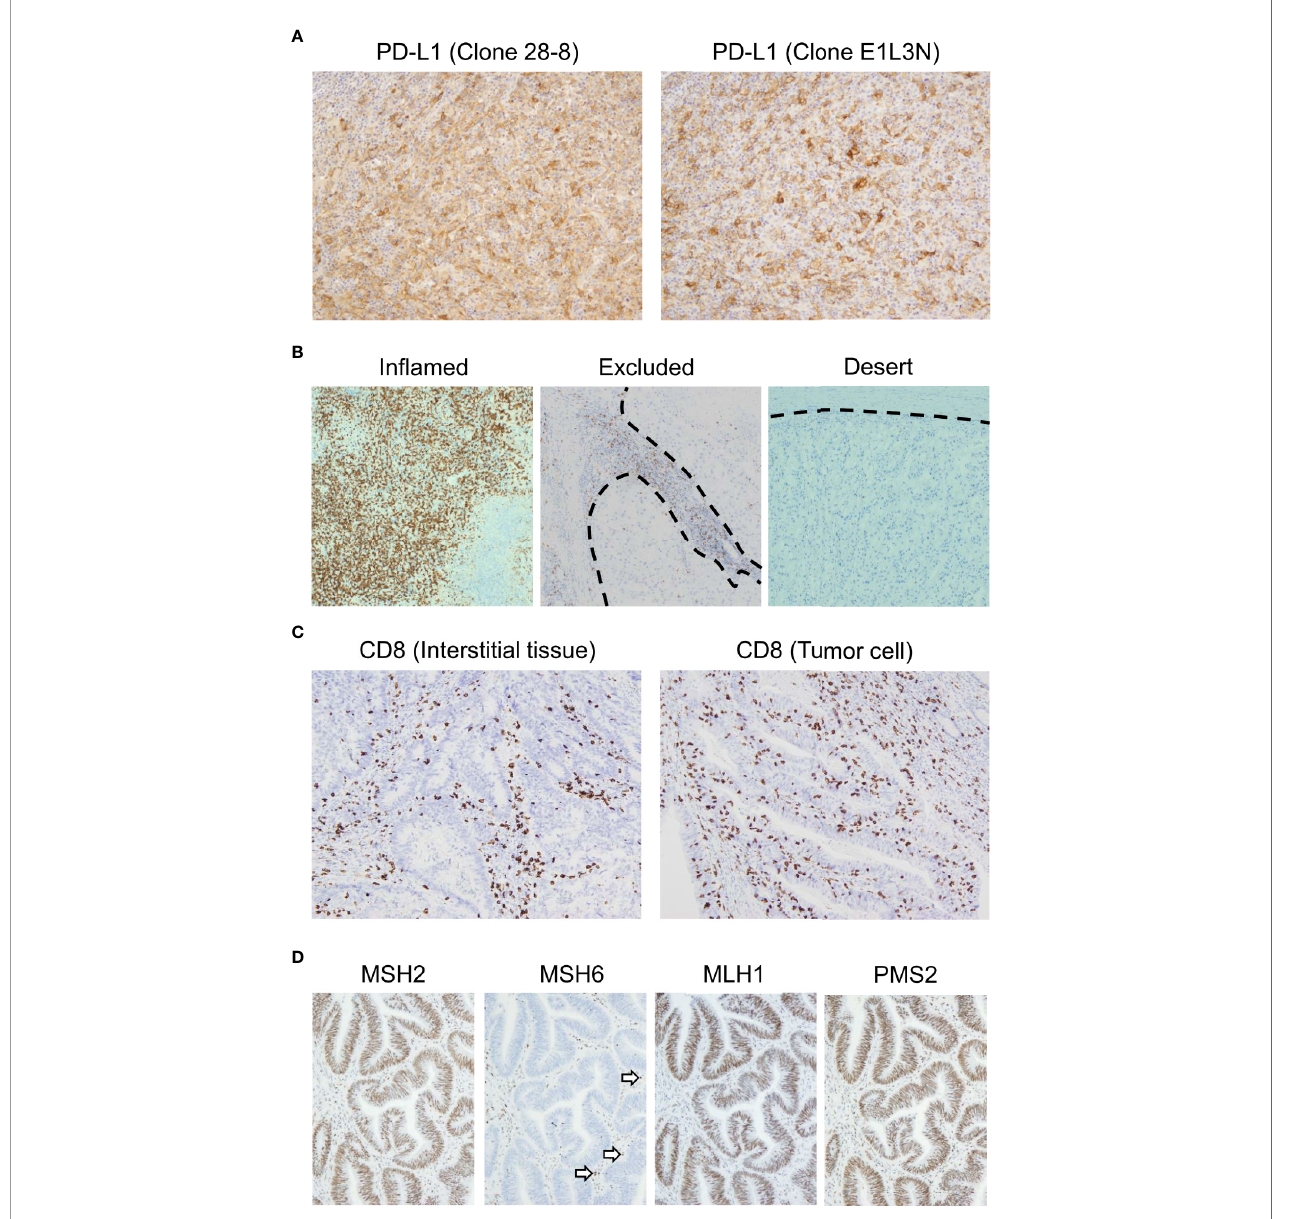
FIGURE 3 | Representative biomarkers estimating the clinical effect of immune checkpoint inhibitors. (A) Differential programmed death ligand 1 (PD-L1) staining at the same site on serial sections in a case of melanoma. Left: 28-8 clone; Right: E1L3N clone. (B) Three major patterns of CD8-positive cell in fi ltration. All cases presented here are clear cell renal cell carcinoma. The dotted line indicates the boundary between the tumor and interstitial tissue. (C) CD8-positive cell in fi ltration pattern of colon adenocarcinoma. The maximum density of CD8-positive cell in fi ltration in these two cases is at the same level. In the left case, CD8-positive cells in fi ltrated mainly the interstitial tissue. Meanwhile, CD8-positive cells also in fi ltrated the tumor tissue. (D) Immunohistochemistry for MutS protein homolog 2 (MSH2), MutS protein homolog 6 (MSH6), MutL protein homolog 1 (MLH1), and postmeiotic segregation increased 2 (PMS2) in colon adenocarcinoma. MSH2, MLH1, and PMS2 are stained in the nucleus. However, MSH6 staining is lost, indicating DNA mismatch repair protein de fi ciency. The staining has to be veri fi ed with an internal positive control. Note that some of the in fi ltrated mononuclear cells show nuclear staining